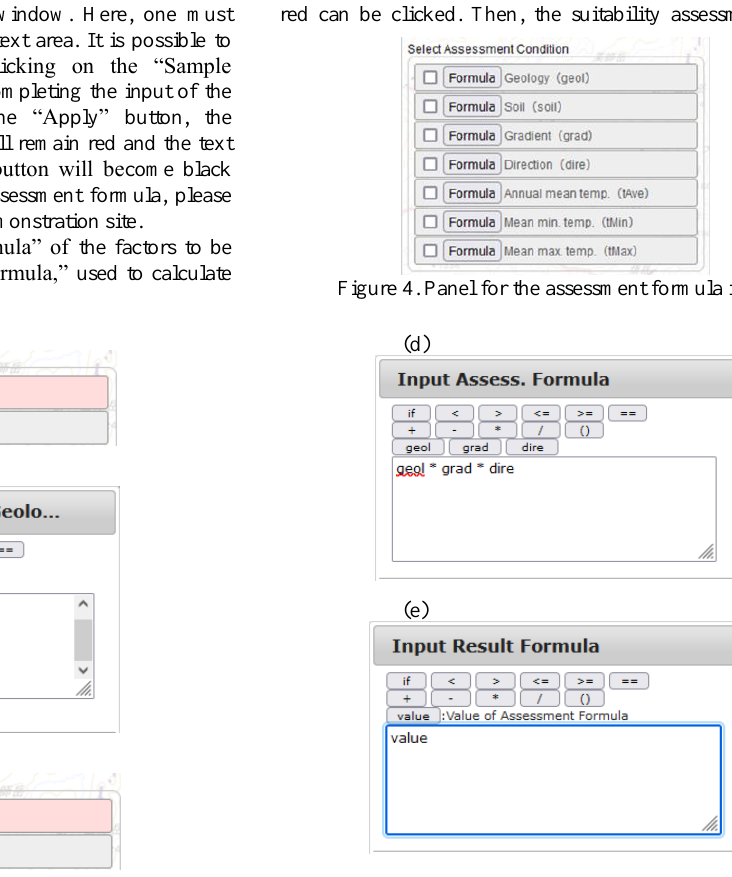
Figure 5. Example of assessment formula